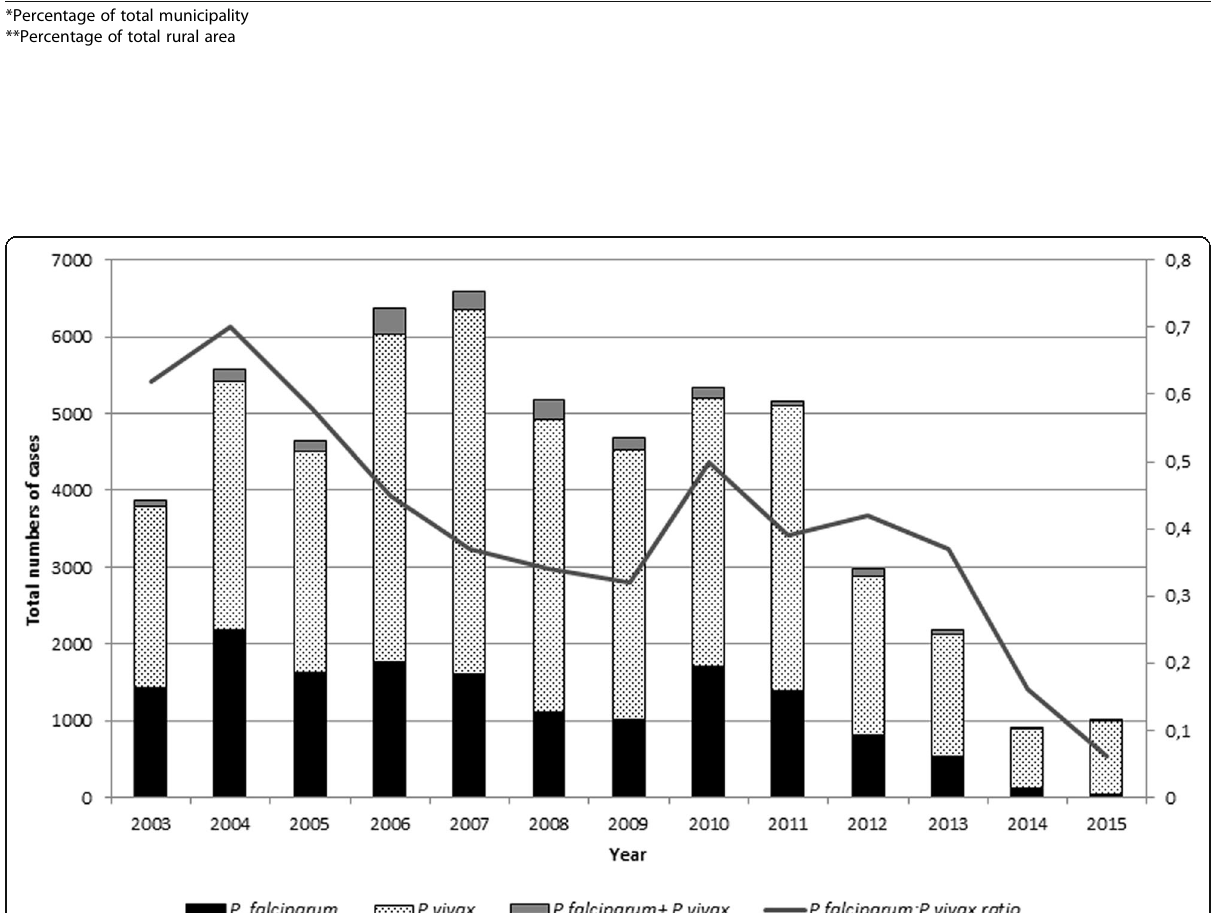
Fig. 4 Proportion of cases by parasite species and rate of Falciparum + vivax between 2003 and 2015. Source: Sivep-Malaria